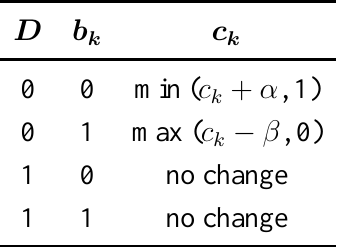
Table 3. Updating c